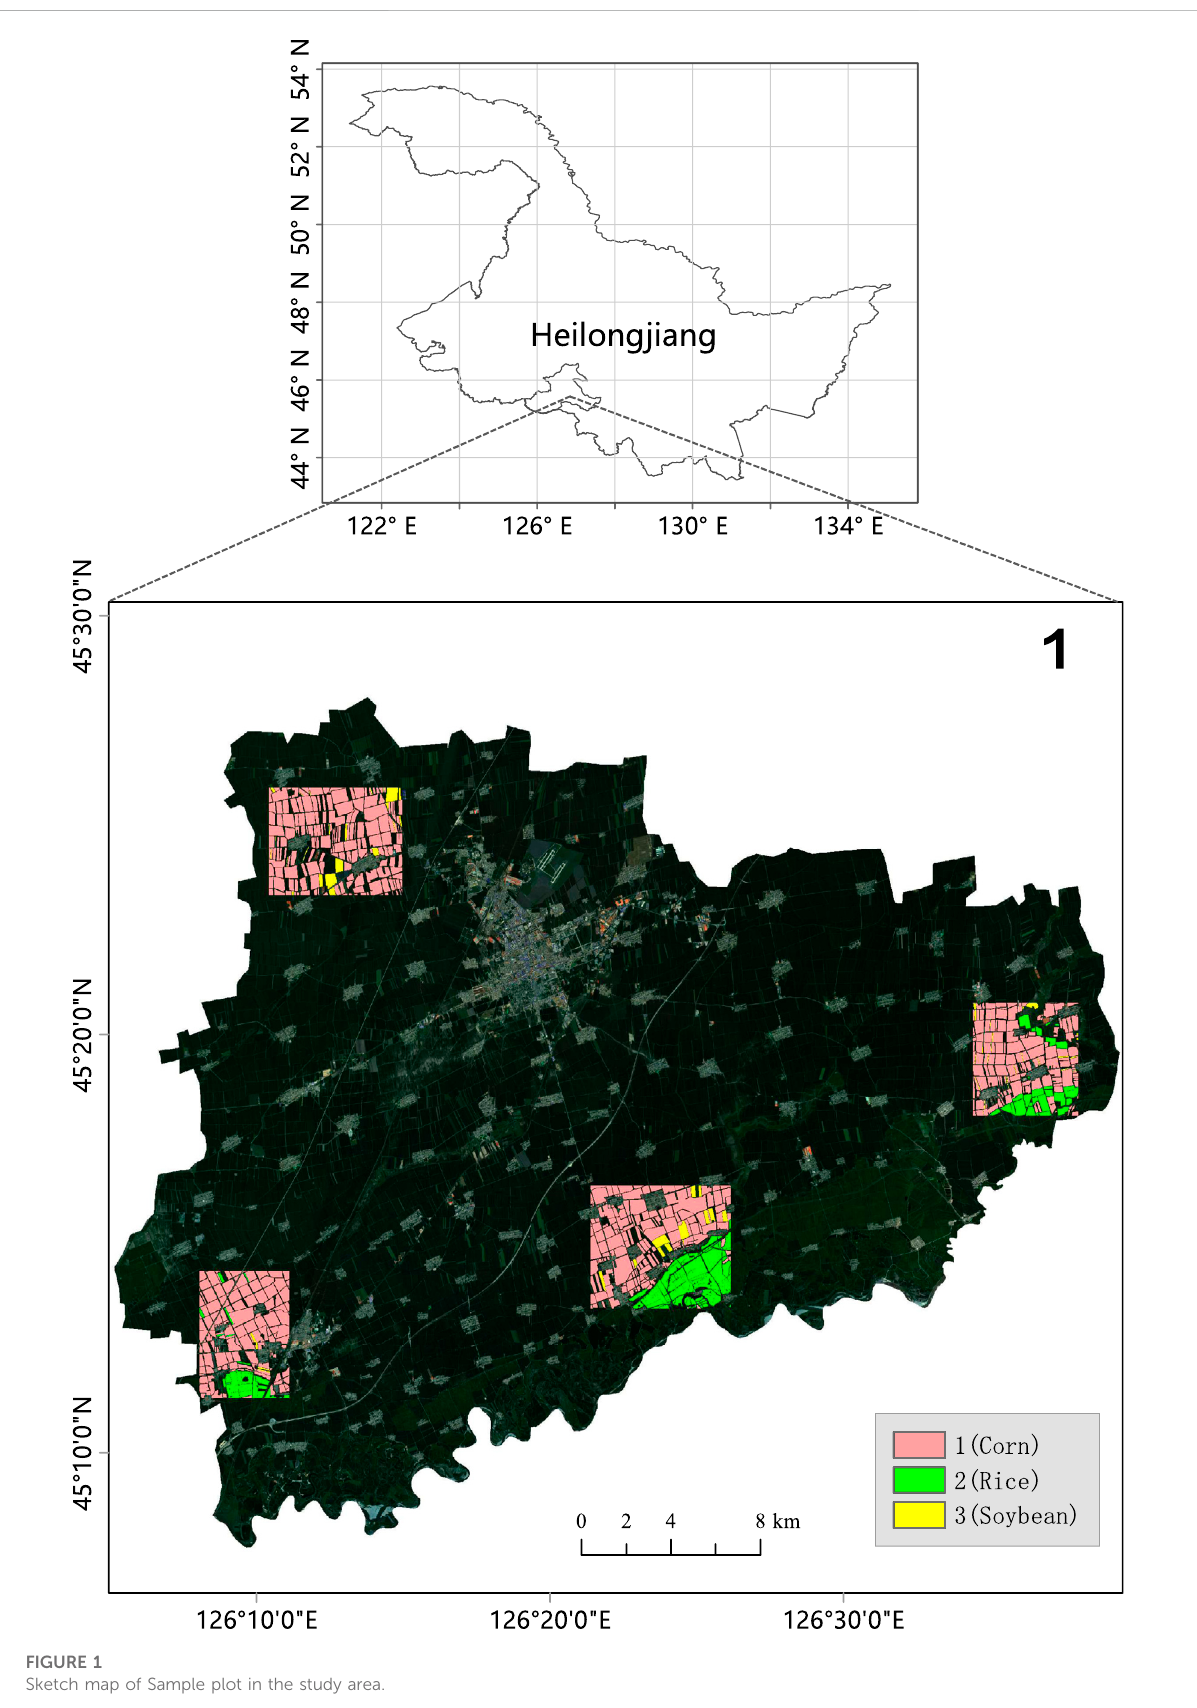
FIGURE 1 Sketch map of Sample plot in the study